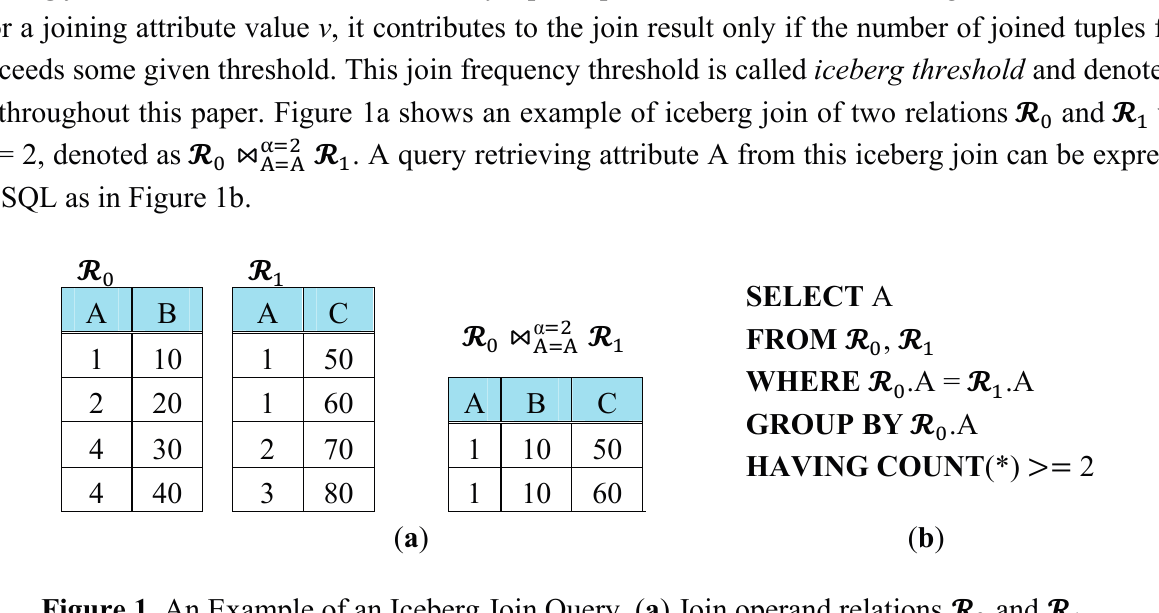
and (cid:2332) , (cid:2868) (cid:2869)